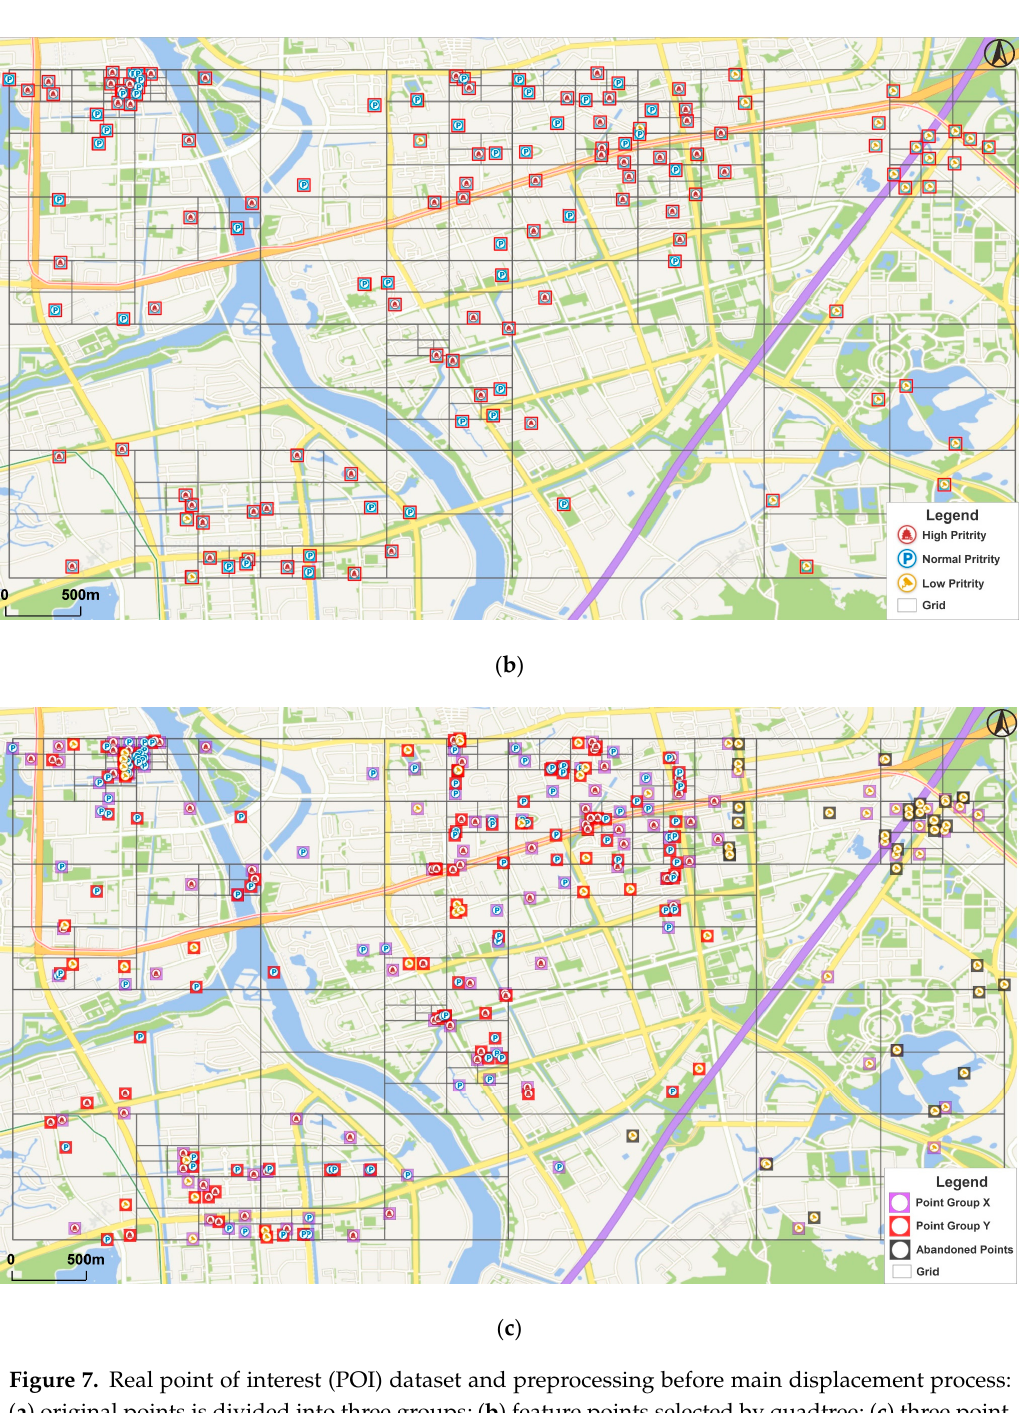
Figure 7. Real point of interest (POI) dataset and preprocessing before main displacement process: ( a ) original points is divided into three groups; ( b ) feature points selected by quadtree; ( c ) three point groups represented by different colors.